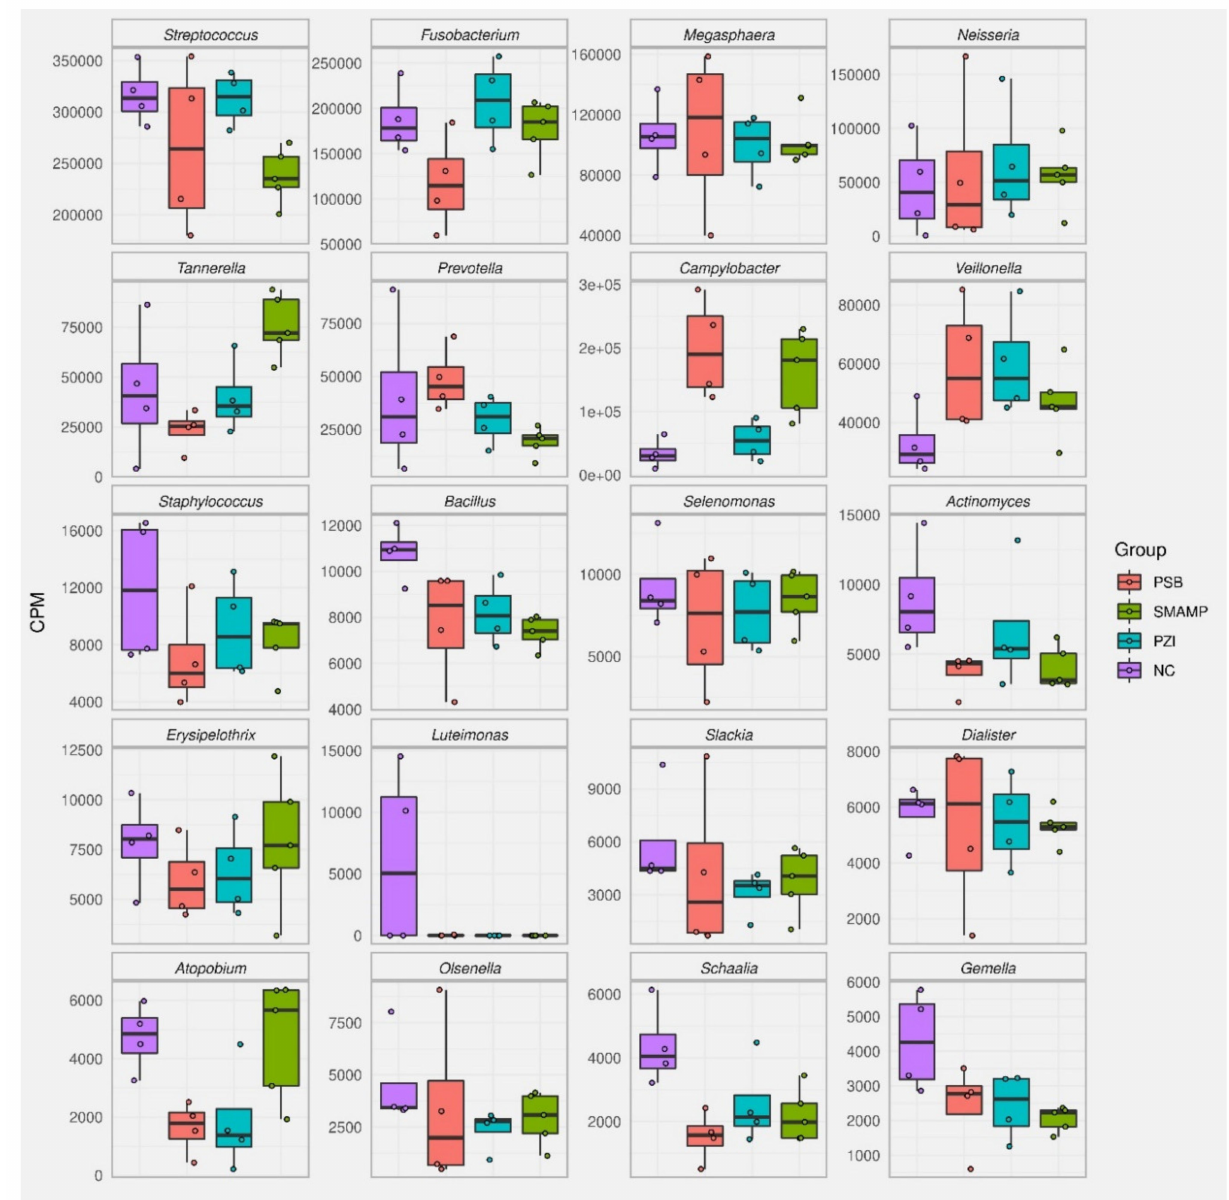
Figure 5. Top 20 most abundant bacterial genera, presented as CPM, for bacteria harvested from native biofilms grown on uncoated substrates ( NC , purple), and bacteria harvested from biofilms grown on polymer-coated substrates ( PSB , red; PZI , turquois; SMAMP ,